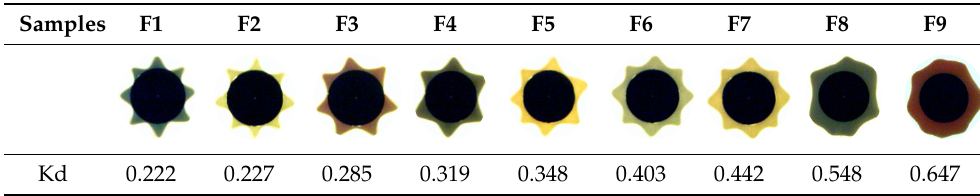
Figure 2. Fabric drape test on a Cusick drape meter. Table 3. Measured values of drape coefficient for nine selected fabrics (F1–F9).